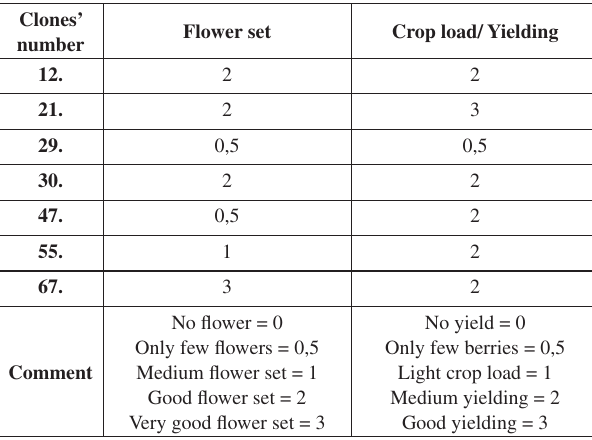
Table 5. Flower set and crop load data based on estimation method in two-year-old Lycium orchard in 2011.